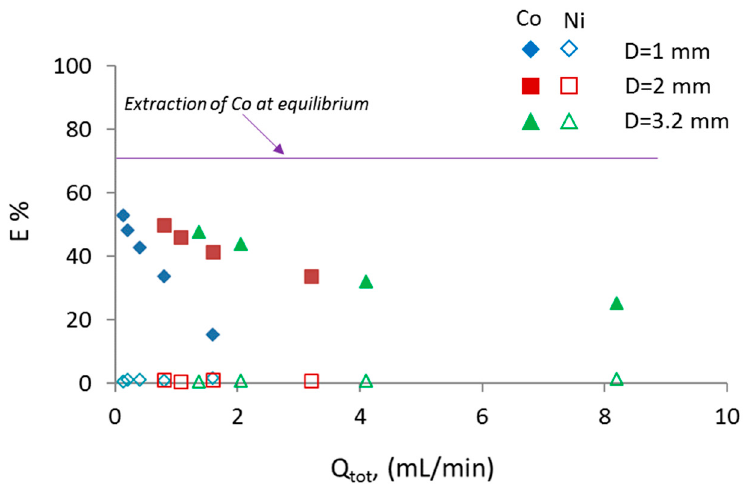
Figure 6. Extraction percentage of Co(II) and Ni(II) as a function of total flowrate (Q tot ) at different channel sizes for a constant reactor length (L r = 8.5 cm).